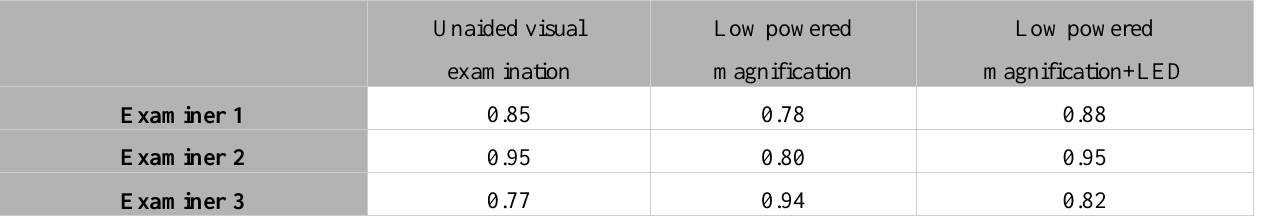
Table 3. Intraexaminer reproducibility of ICDAS examinations (Weighted Kappa) for Primary